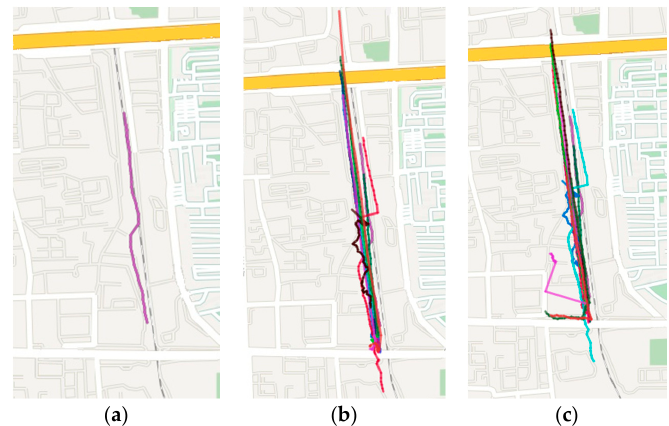
Figure 10. Query results of trajectory sequences with the SDTW and DTW algorithms. ( a ) The original query trajectory; ( b ) Query results of trajectory sequences with the SDTW; ( c ) Query results of trajectory sequences with the DTW algorithms.